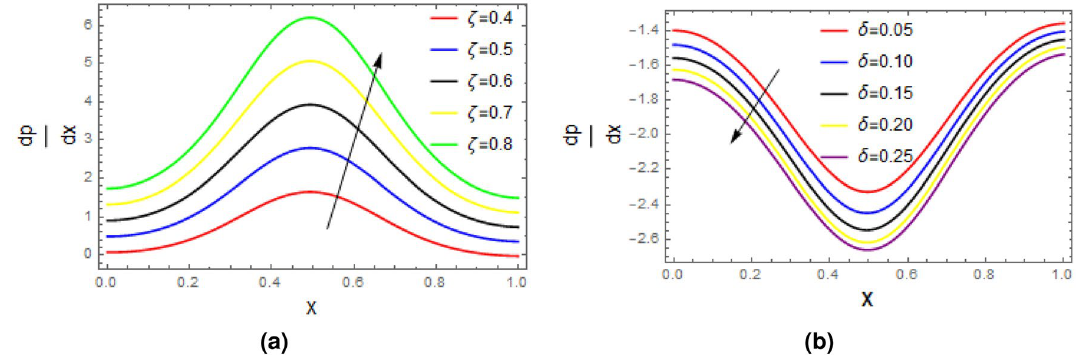
Figure 9. Plots of pressure gradient, impacts of ζ and δ are studied with α = 1, ε = 0.2, Q = 0.5 ( a ) δ = 0.05 , ( b ) ζ = 0.05 .